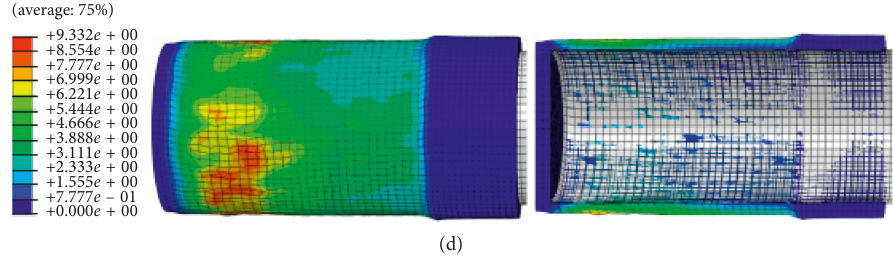
Figure 12: Third-pass equivalent strain distribution. (a) 25%. (b) 50%. (c) 75%. (d) 100%.